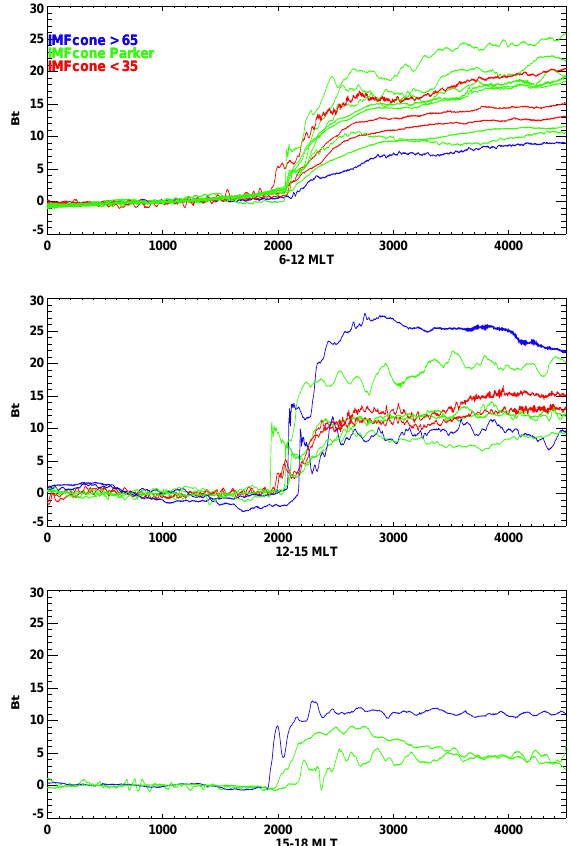
Figure 7. GOES spacecraft observations of the total magnetic field jump for 24 events in our data set, organized according toMLT. The Fig. 7. GOES spacecraft observations of the total magnetic field mean level of the total magnetic field before the IP shock response jump for 24 events in our data set organized according to MLT. The ( B t in nT) has been subtracted. First panel shows the observations in mean level of the total magnetic field before the IP shock response which the spacecraft were located between 6 to 12MLT, the central (B t in nT) has been subtracted. First panel shows the observations panel between 12 and 15MLT, and the last panel between 15 to when the spacecraft were located between 6 to 12 MLT, the middle 18MLT. The scale of the x axis is 1 point = panel between 12 and 15 MLT, and the last panel between 15 to 18 MLT. The scale of the x-axis is 1 point = 0.512 s.